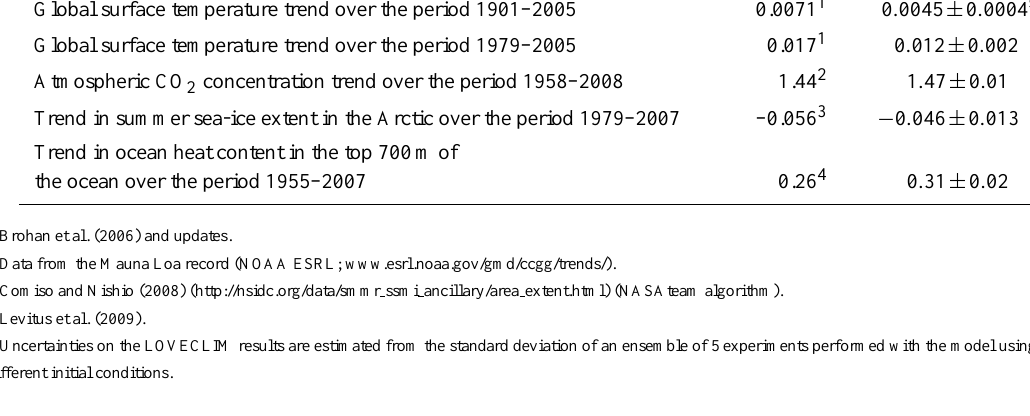
Table 7. Simulated trends over the last decades of some important variables. Variable